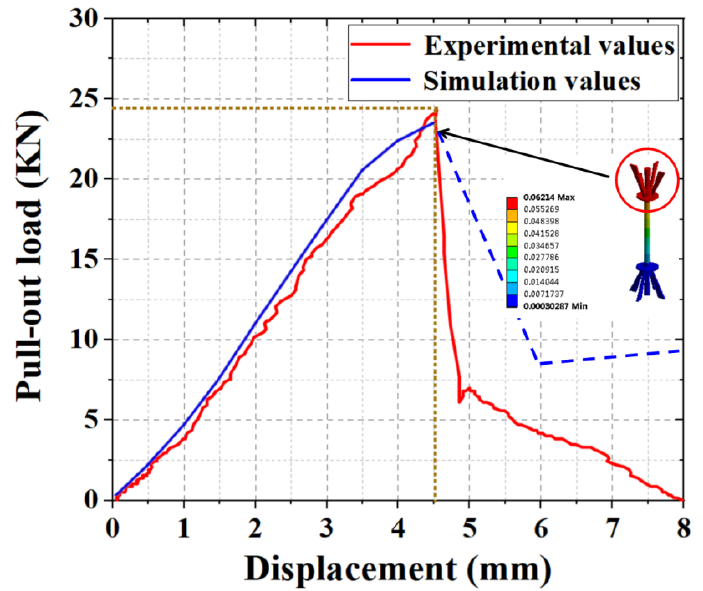
Figure 13. Comparison load–displacement curves of the experimental and simulated pull-out tests.